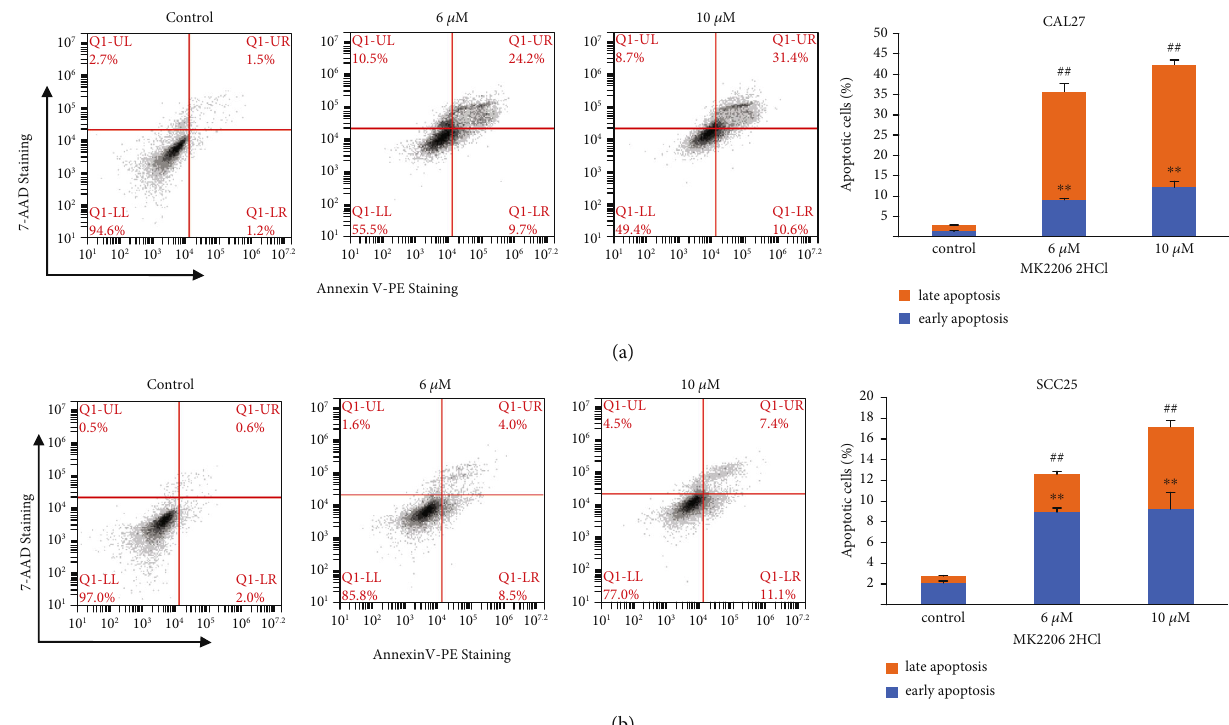
Figure 8: MK2206 2HCl promoted the apoptosis of OSCC cells. (a) MK2206 2HCl treatment for 24h promoted the early and late apoptosis of CAL27 cells. (b) MK2206 2HCl treatment for 24 h promoted the early and late apoptosis of SCC25 cells. All data are presented as the mean ± SD : ∗∗ P < 0 : 01 indicated early apoptotic cells compared with the control group. ## P < 0 : 01 as the late apoptotic cells compared with the control